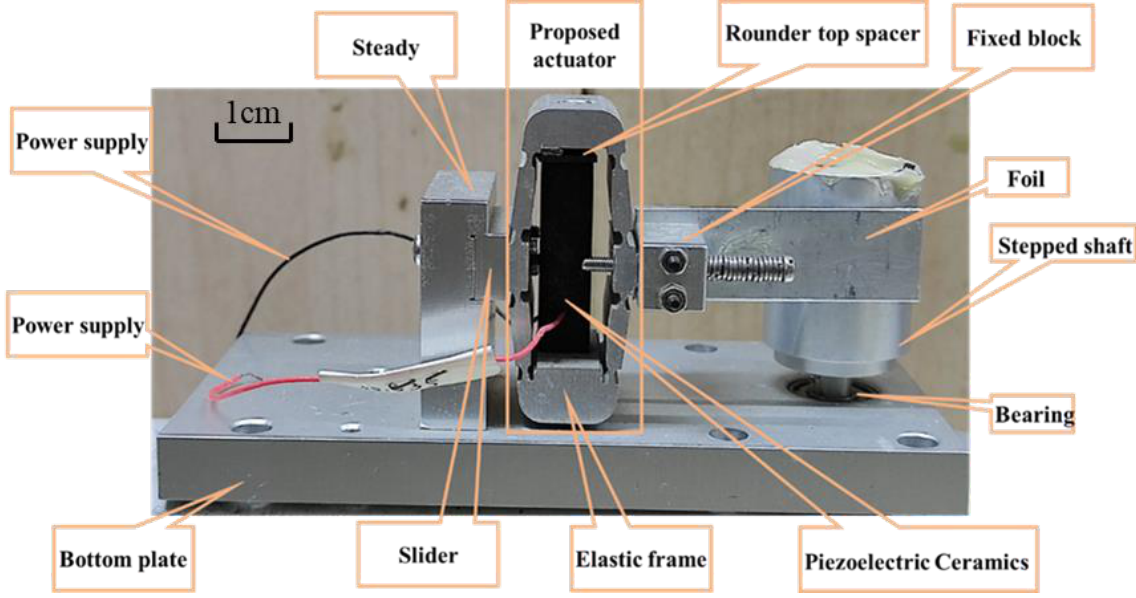
Figure 1. Overall design of panoramic scanning imaging device.